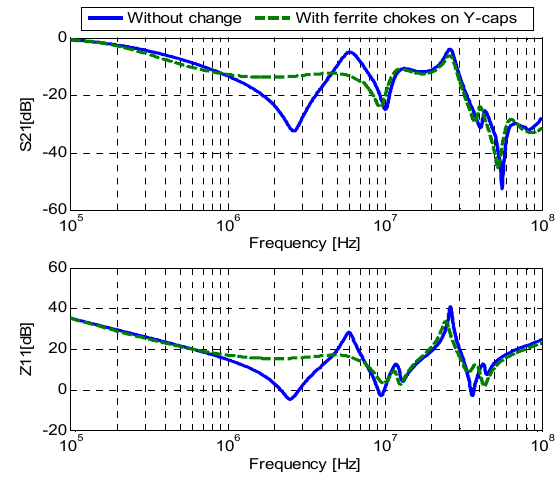
Figure 13. Change in Z11 and S 21 after adding a CM ferrite choke on Y ‐ caps.